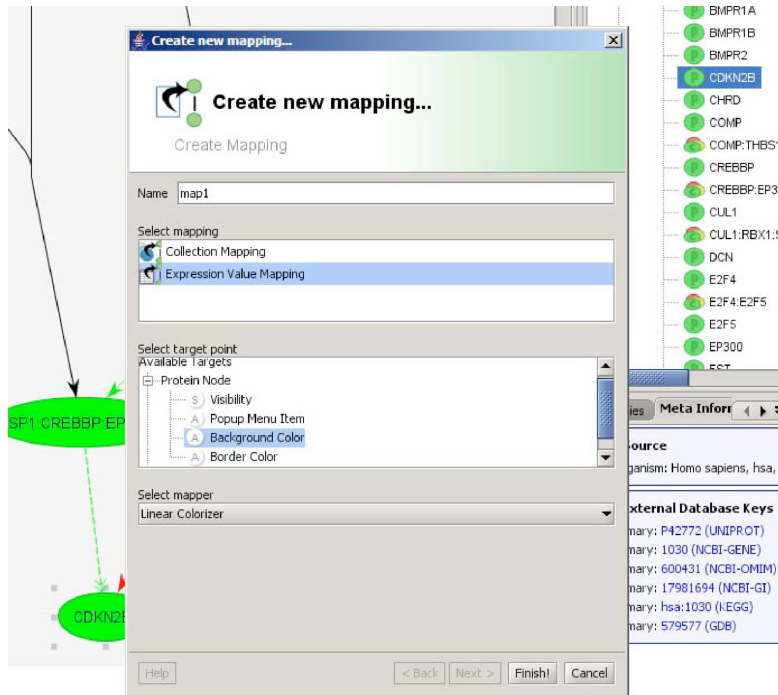
Figure 6: This dialog de fi nes a new mapping of expression values on the background color of protein